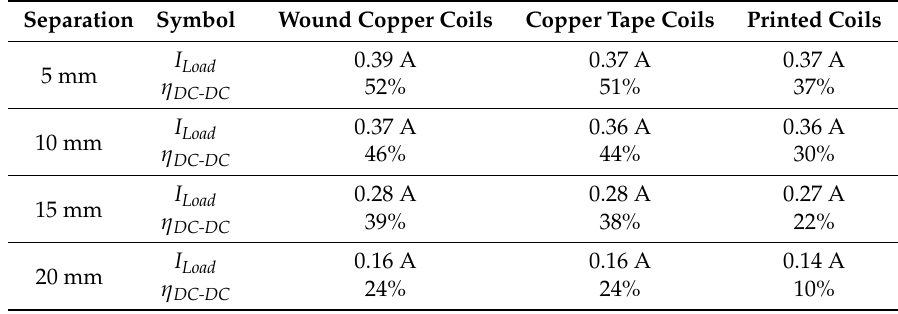
Table 4. Maximum output current and DC to DC efficiency of wireless power transfer system deployed with different coils.